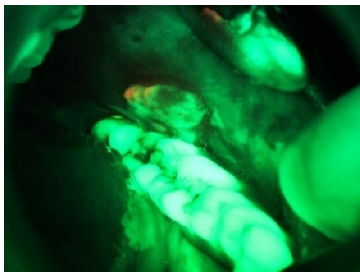
Figure 15. VELscope ® image without device area.